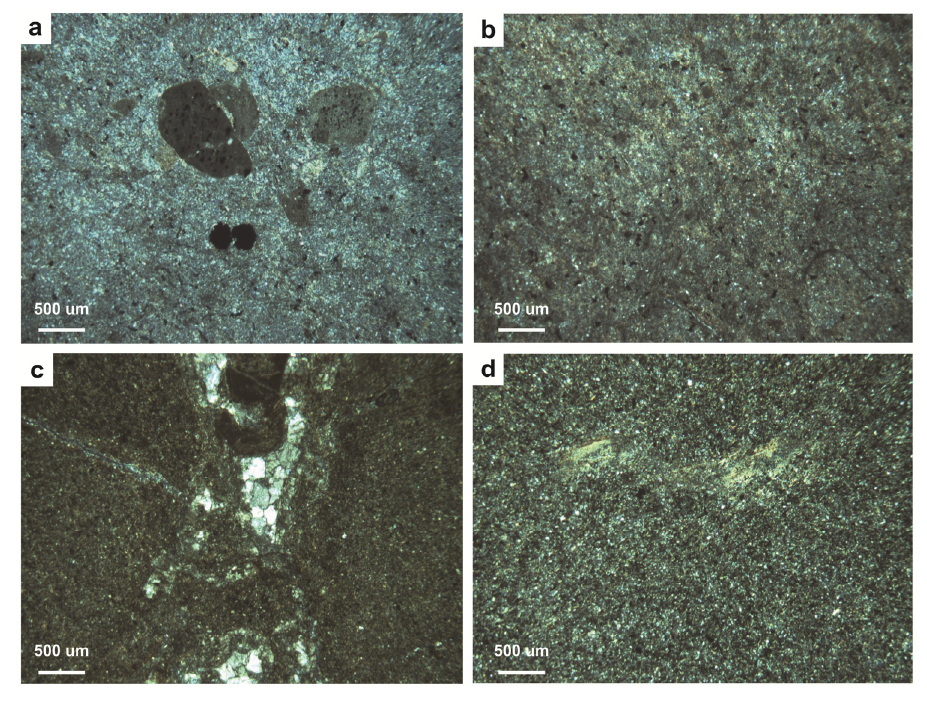
Figure 8. Microfabrics from Type C paleosols: ( a ) An agglomeroplasmic soil microfabric; ( b ) An insepic plasmic microfabric with small pyrite crystals within the matrix; ( c ) A calciasepic soil microfabric surrounding a fracture that is filled with calcite spar; ( d ) A high birefringence streak of clay within a mosepic plasmic